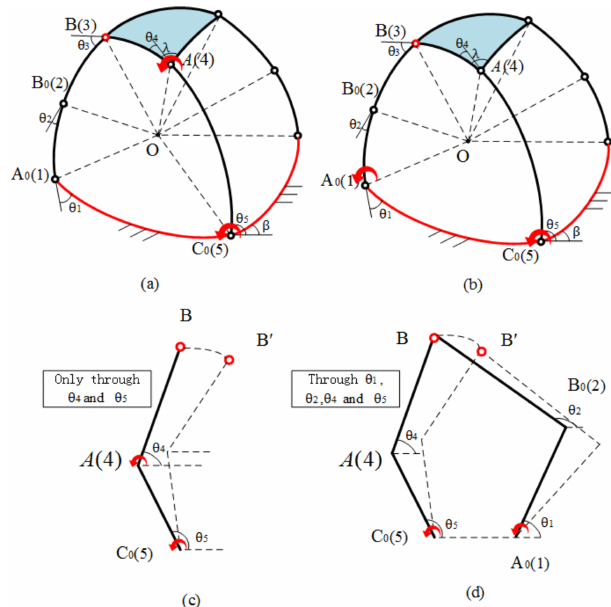
Figure 2. Two kinds of input joints and corresponding motion sim- plification diagrams. (a) Input joints at A and C 0 , (b) input joints at A 0 and C 0 , (c) motion only through θ 4 and θ 5 when input joints are at A and C 0 , and (d) motion through θ 1 , θ 2 , θ 4 , and θ 5 when input joints are at A 0 and C 0 .